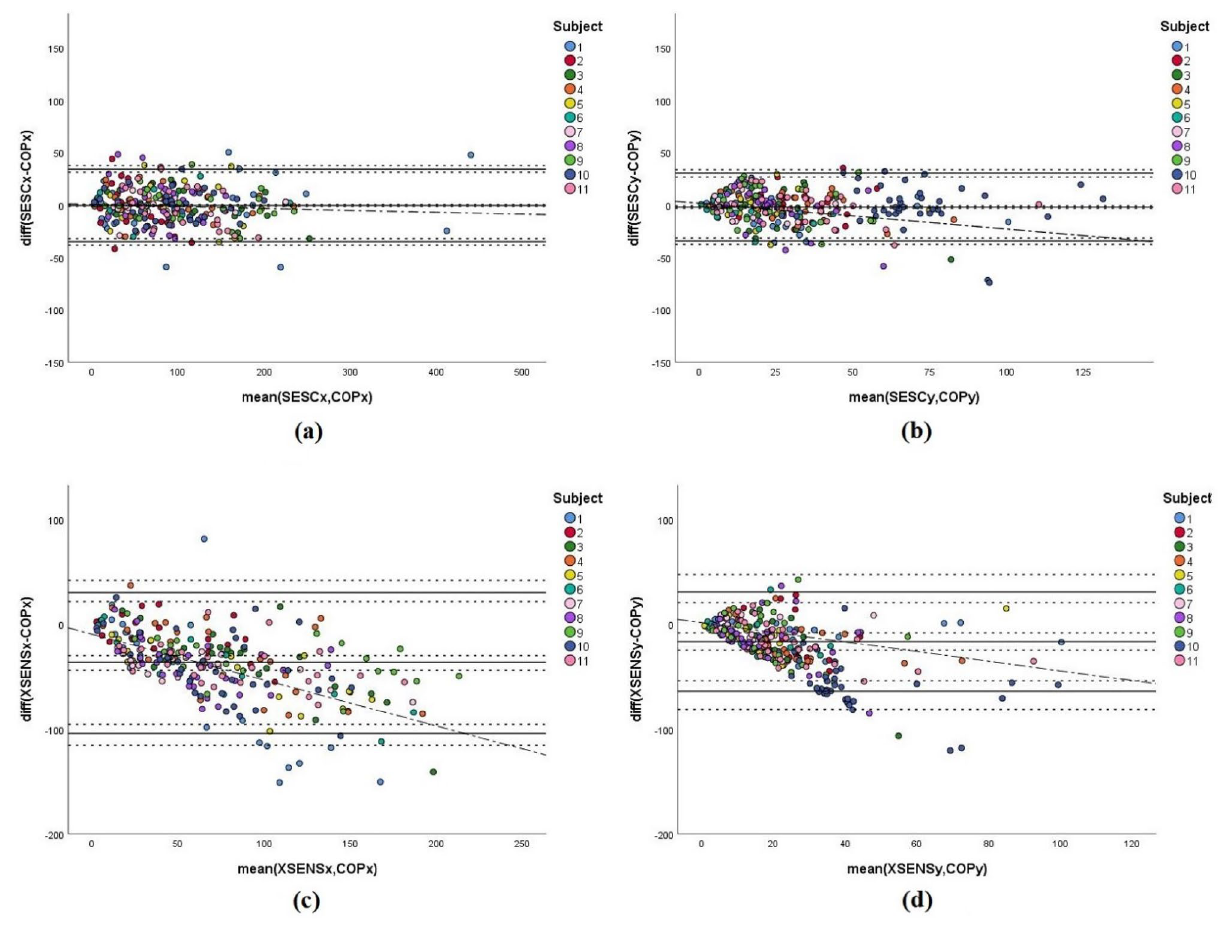
Figure 3. Bland–Altman plots of the CoM estimations against the CoP readings for subjects belonging to the Fit group. Mean bias and limits of agreement are shown by the straight black lines, while confidence intervals are shown by the dotted lines. ( a ) represents the SESC estimations in the AP direction, ( b ) represents the SESC estimations in the ML direction, ( c ) represents the XSENS estimations in the AP direction, and ( d ) represents the SESC estimations in the ML